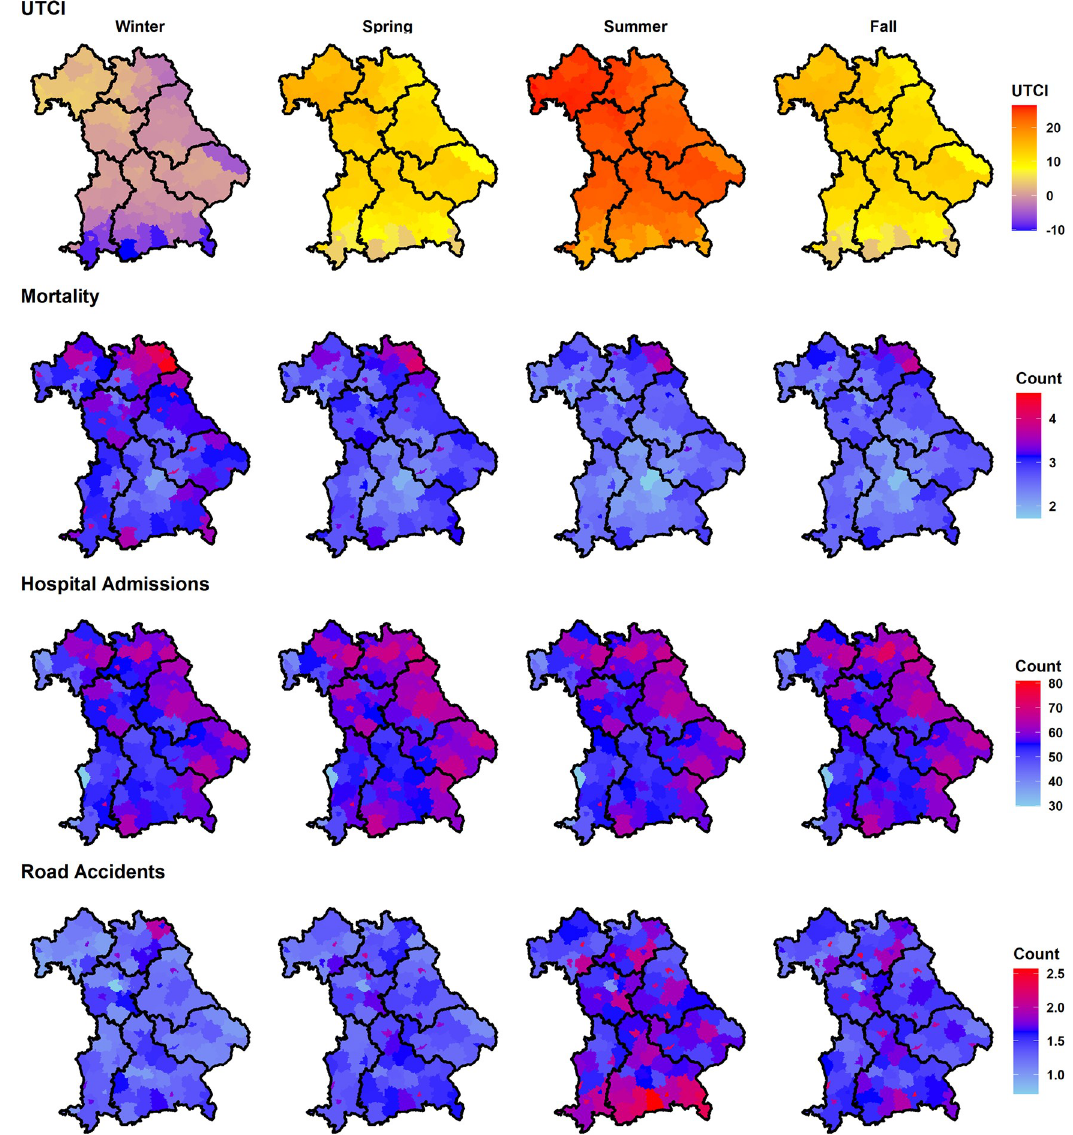
Fig 2. Summary of the data by season and region/district. The upper row of panels contains for each district the average UTCI value calculated for the corresponding season over the study period (1995–2015). The numbers of daily cases per 100,000 inhabitants are averaged for mortality (second row) and for hospital admissions (third row) over 1995–2015. The lower panel row represents the daily number of road accidents per 100,000 inhabitants averaged over 2002–2015. Border shapefiles were provided with written permission by the Bundesamt fu¨r Kartographie und Geoda¨sie under the license (CC BY 4.0).